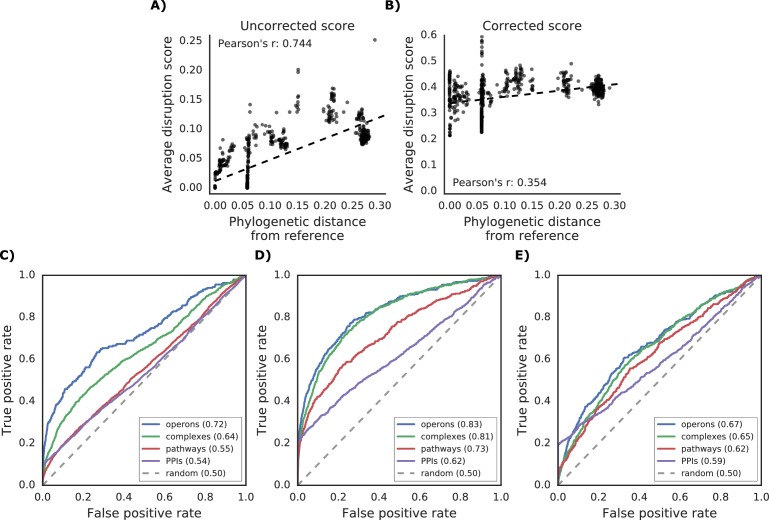
Additional properties of the gene disruption score.(A) Correlation between phylogenetic distance from the reference strain and average disruption across all reference genes. (B) Significant reduction in correlation after correction of the disruption score (see Materials and methods). (C–E) Prediction of gene functional associations using disruption score profiles. (C) ROC curve using disruption score profiles across all genes. (D–E) Higher predictive power of the gene disruption profile when restricted to accessory genes, including (D) or not (E) the information about gene presence absence.